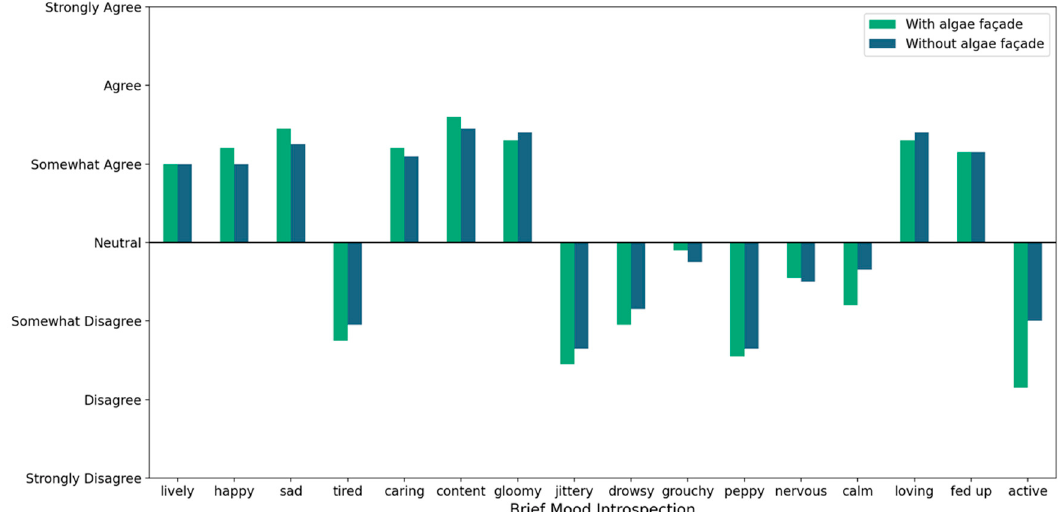
Figure 4. Effect of the algae facade on the Brief Mood Introspection after design tasks completion. Average across participants in each group on a 7-point likert scale (strongly disagree to strongly agree). Participants agreed that they felt lively, happy, caring, loving, and less nervous in the controlled room.